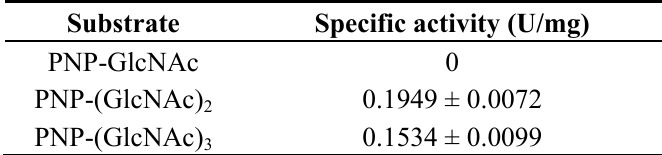
Table 1. Substrate specificity of pancreatin.